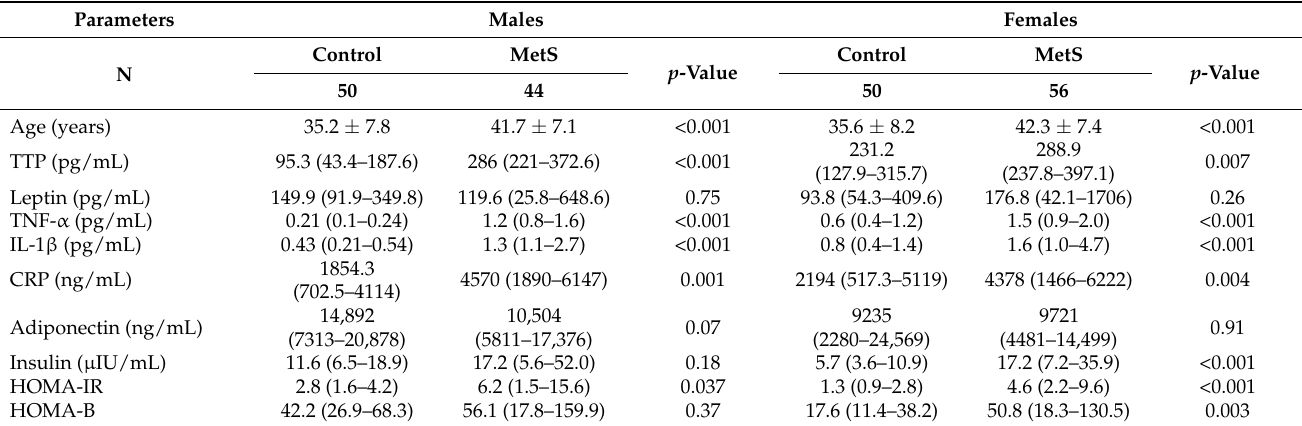
Table 2. Comparison of clinical characteristics between males and